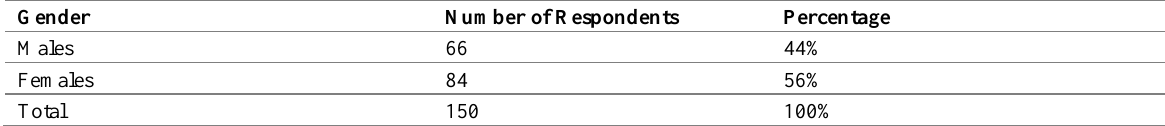
Table 4: Characteristics of Respondents by Gender